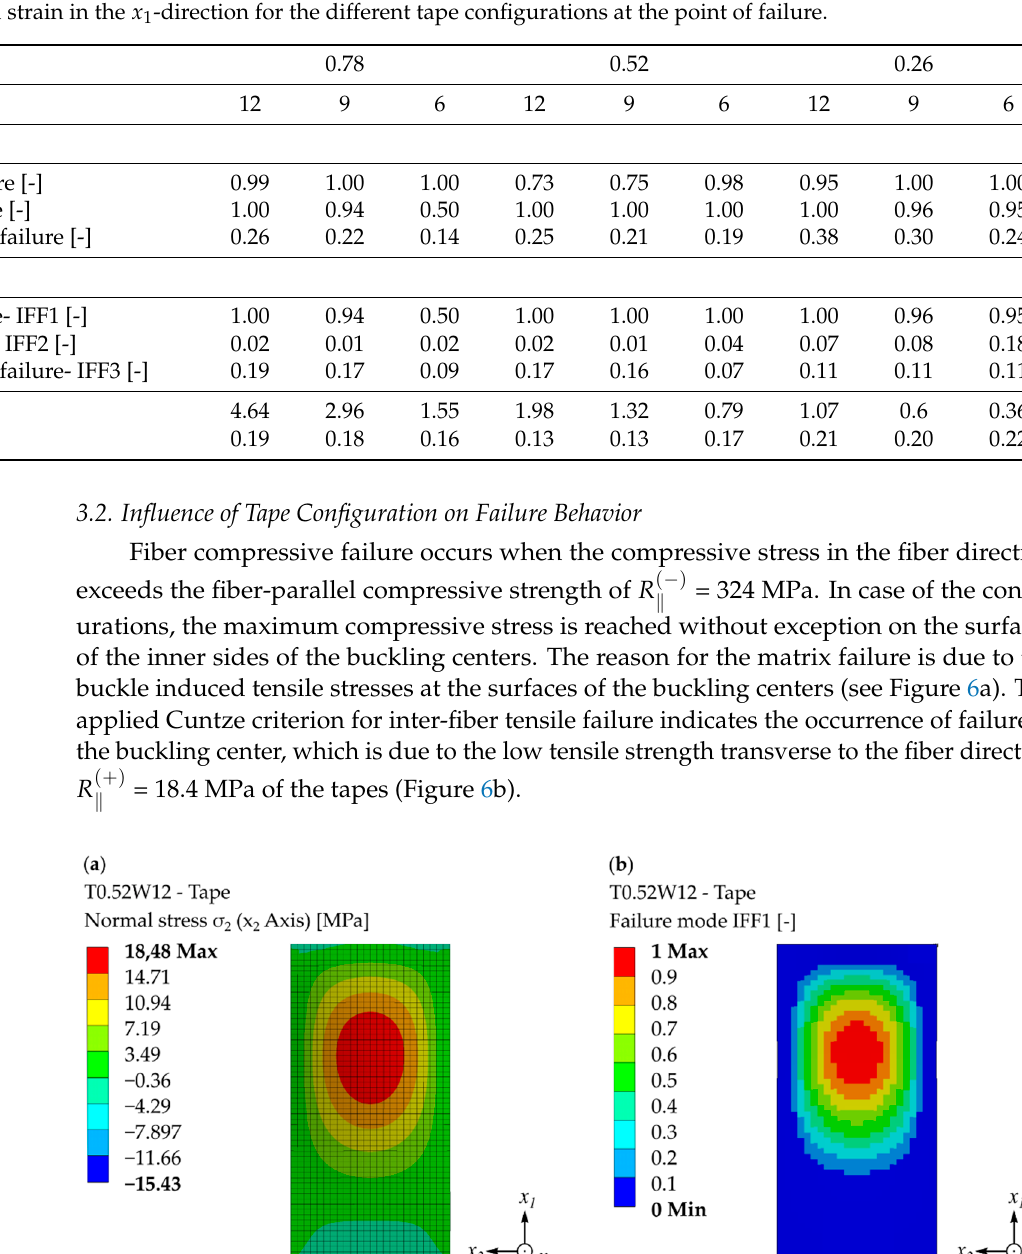
Figure 7. Comparison of the normal stress 𝜎 (cid:2870) distribution of the three tape widths ( a ) 12 mm, ( b ) 9 mm and ( c ) 6 mm with a tape thickness of 0.26 mm at the point of failure.